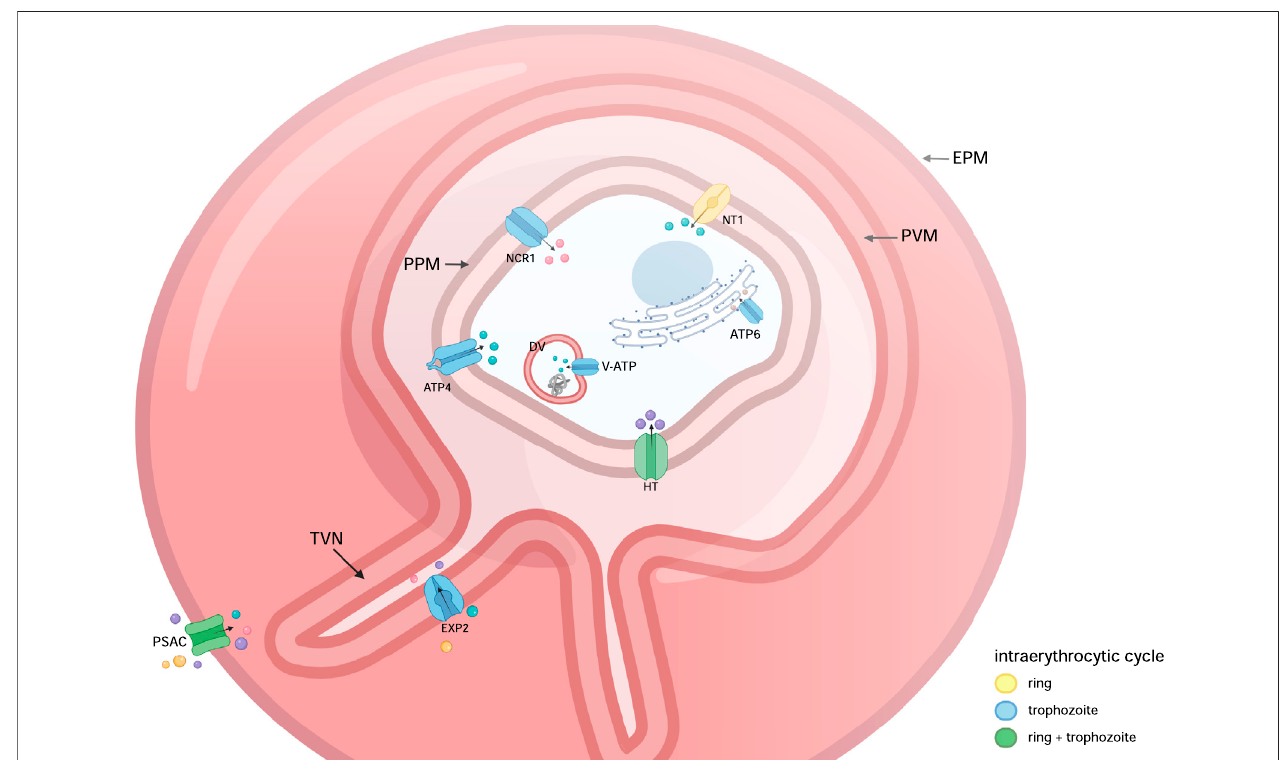
FIGURE1 | In the P. falciparum -infected red blood cell, several transporters representpotentialdrug targets. The only Plasmodium spp.transporter in theEPM so far being evaluated as a drug target is PSAC responsible for passage of a broad range of solutes. Not too many transporters are known at the PVM with EXP2 being suggested as a potential target recently, forming a non-speci fi c high-conductivity pore. The PPM contains most transporters investigated as drug targets, such as HT, FNT,NT1,NCR1andATP4.Insidetheparasite,transportersfacilitatefunctionofdiverseorganelles,suchasATP6intheendoplasmicreticulum.Thecolorscheme of transporters indicates in which stages of the intra-erythrocytic life cycle the is expressed. EMP, erythrocyte plasma membrane; PVM, parasitophorous vacuolar membrane; TVN, tubovesicular network; PPM, parasite plasma membrane; PSAC, plasmodial surface anion channel; VDAC, voltage-dependent anion channel; EXP2, exported protein 2; HT, hexose transporter; NT1, nucleoside transporter 1; NCR1, Niemann-Pick type C1-related protein; ATP4, P-type Na + -ATPase 4; ATP6, sarco/ endoplasmic reticulum Ca 2+ -ATPase; DV, digestive